Question: Express in one sentence what the figure is showing.
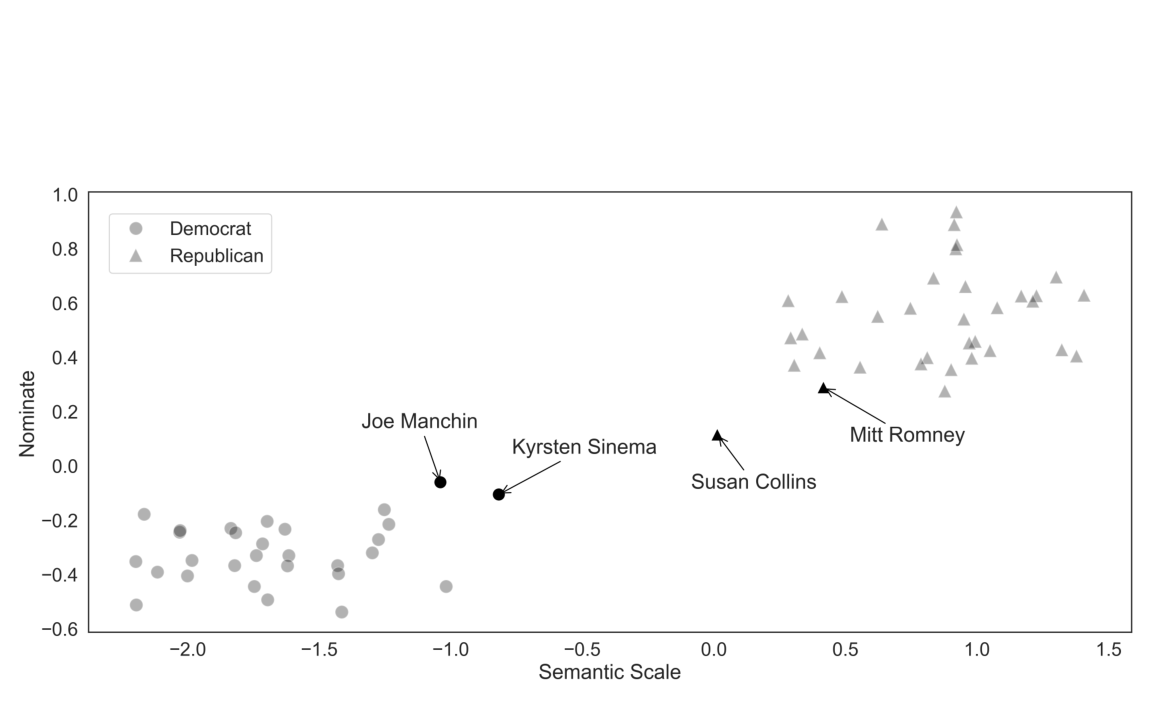
Answer: Both DW-NOMINATE and Semantic Scaling predict Mitt Romney, Susan Collins, Kyrsten Sinema, and Joe Manchin to be among the most moderate members of the Senate.